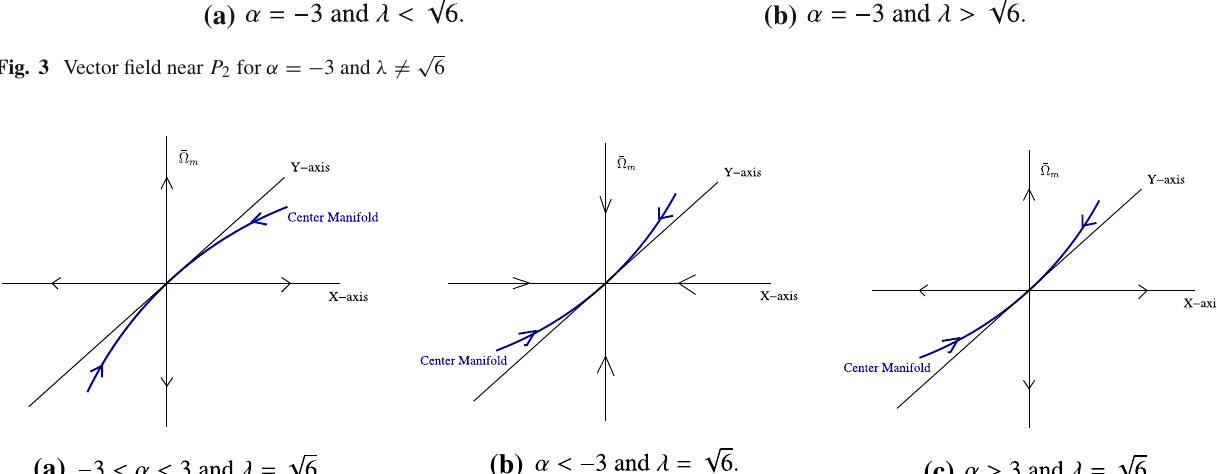
Fig. 4 Vector field near P 2 for α (cid:6)= ± 3 and λ =